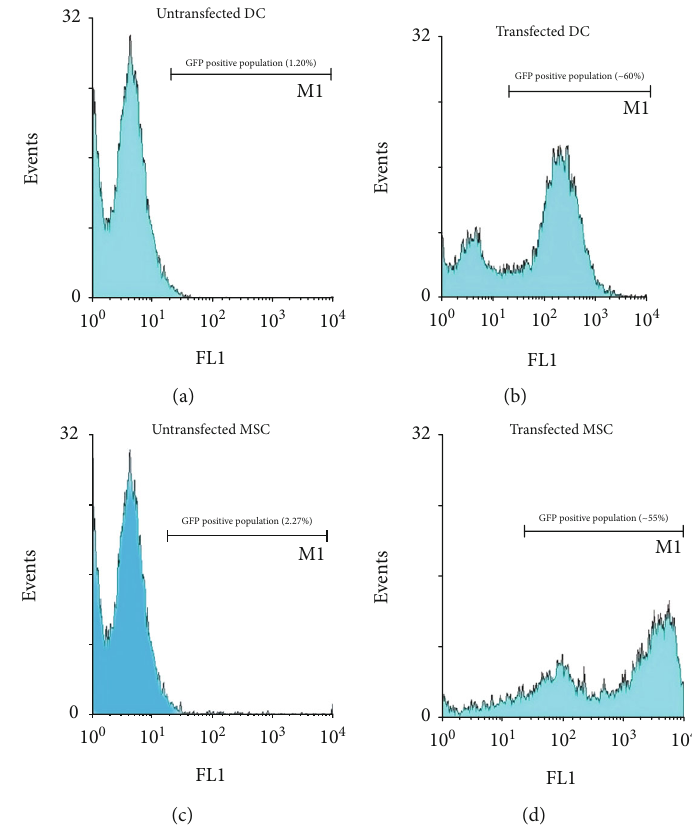
Figure 4: Transfection rates of DCs (b) and MSCs (d) with pEGFP-Nef using both Lipofectamine and equiaxial cyclic methods. Untransfected DCs (a) and MSCs (c) were shown as a negative control. Table 2: Flow cytometry analysis of gene expression under mechanical and chemical treatments in DCs. Methods